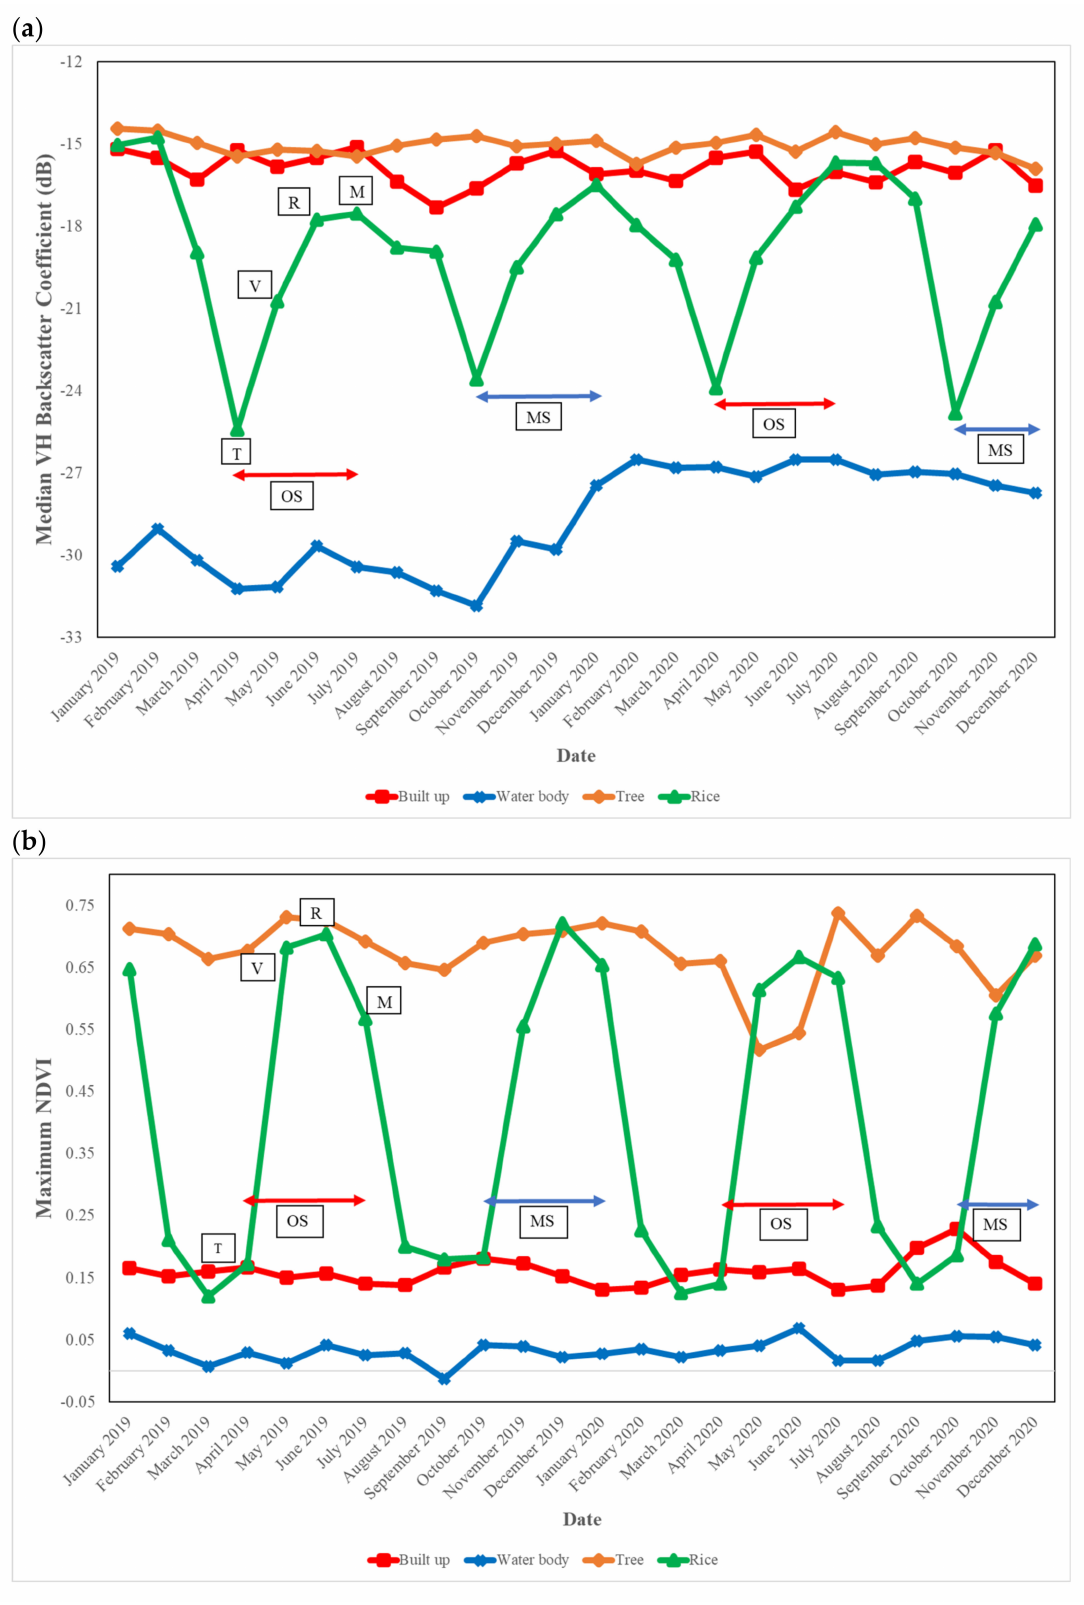
Figure 3. Temporal evolution of the ( a ) VH and ( b ) NDVI polarization cluster profile of four land- cover classes: built-up, tree, water body and rice field; T = tillage and planting, V = vegetative, R = reproductive, M = maturity, MS = main season, OS = off